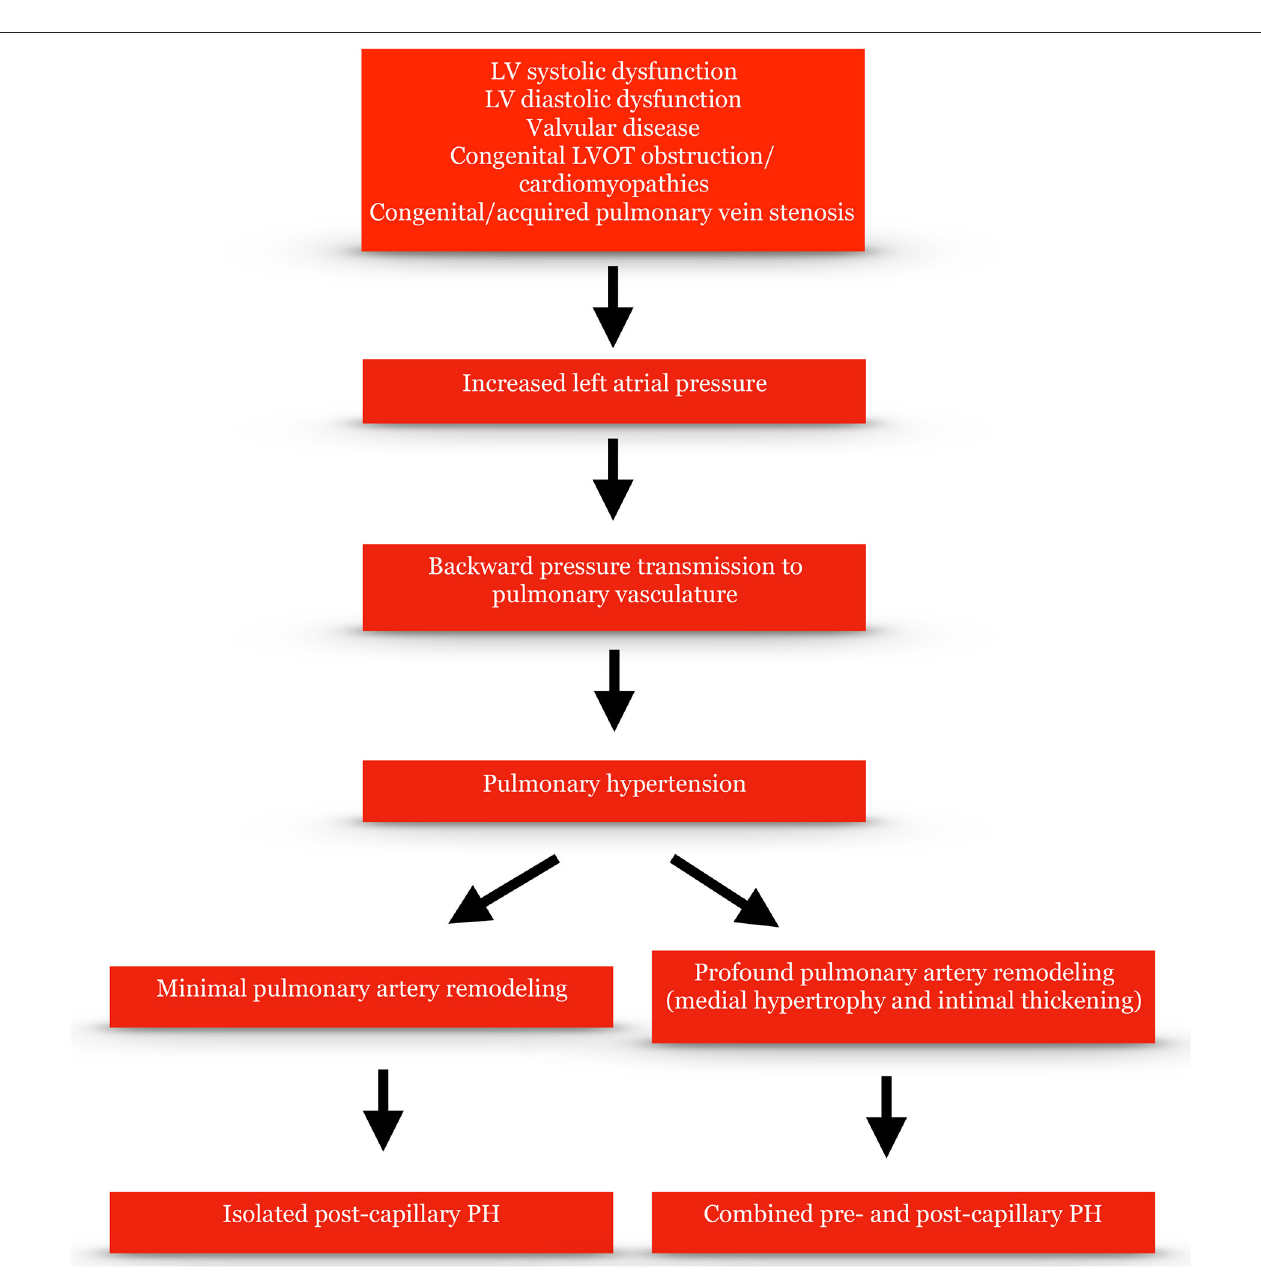
FIGURE 1 | Pathophysiological mechanisms of pulmonary hypertension due to left heart